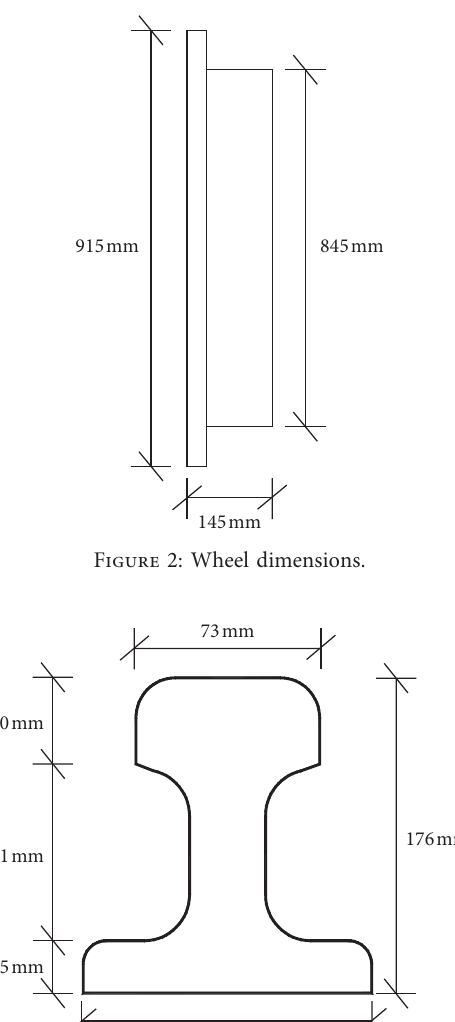
Figure 3: Detailed dimensions of the track.